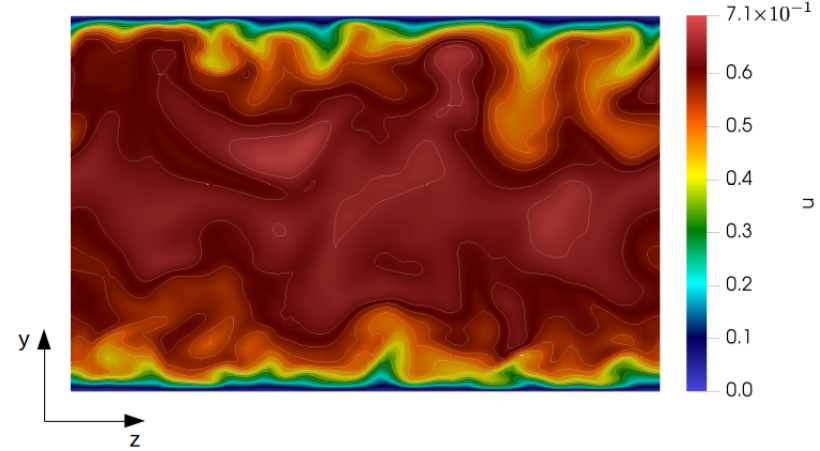
Figure 20. Instantaneous streamwise velocity contour at yz plane located at the channel half length for the particles free case.